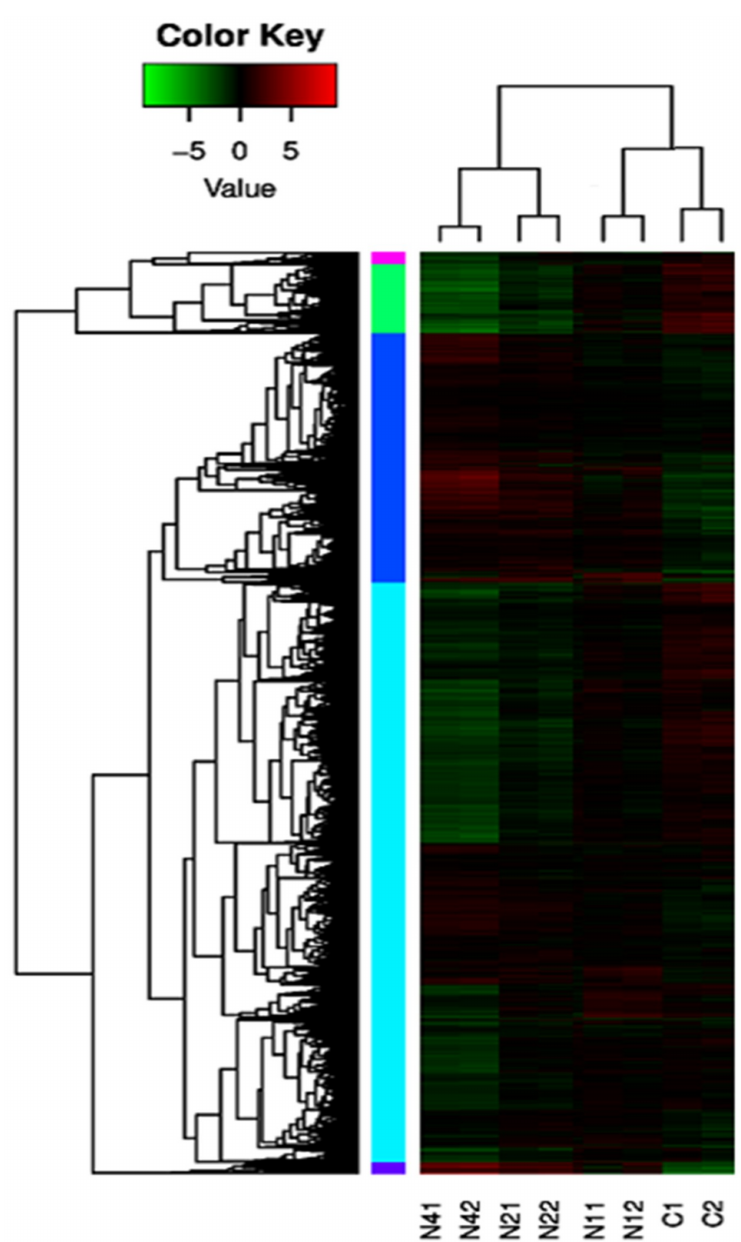
Figure 5. Cluster diagram of DEUs (FDR ≤ 0.05, fold change ≥ 2). The darker color represents the higher of the gene expression level. Each color block on the left represents a cluster of genes with similar expression levels. The Log2.FPKM value was used for clustering, with red for high expression gene and green for low expression gene. The color ranges from green to red, indicating higher gene